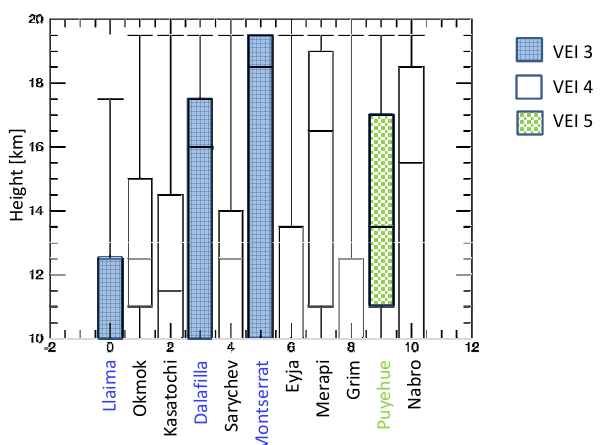
Figure 12. Eruption SO 2 -plume altitudes from this study. The black lines show the range of altitudes retrieved, the boxes depict the al- titude range into which the 50% of the SO 2 mass falls, the hori- zontal lines within each box are the altitudes of the maximum of SO 2 mass. Different colours represent eruptions of different VEI (Source: Global Volcanism Program,